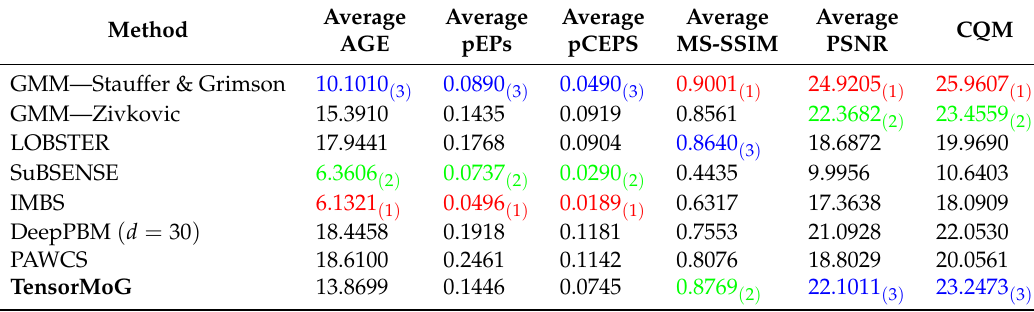
Table 7. Comparison on the Scene Background Modelling (SBMnet)